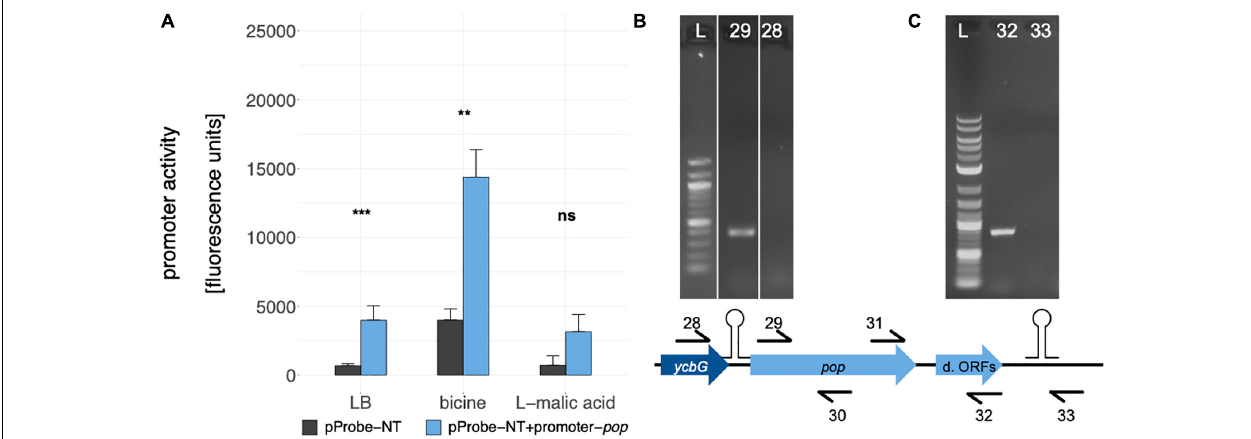
FIGURE 5 | Analysis of the pop transcriptional unit. (A) Promoter activity assay for the promoter of pop , which was introduced in the promoterless GFP vector pProbe-NT. Mean fluorescence units of E. coli Top10 cells with the different constructs in culture conditions as indicated are given. Error bars show standard deviations. Statistical significance between empty vector (gray bars) and the promoter construct (blue bars) was tested with a Welch two sample t -test ( ** p ≤ 0.01; *** p ≤ 0.001; ns, not significant). (B) Test for mono- or polycistronic mRNA. An agarose gel of RT-PCRs is shown. RNA was reverse transcribed in cDNA with pop specific reverse primer 30. Two different forward primers, binding within ycbG (no. 28) or within pop (no. 29), were combined with a pop reverse primer (no. 30). L: 100 bp DNA Ladder (NEB); 28: PCR with primers 28 + 30; 29: PCR with primers 29 + 30. (C) Test for the predicted rho-independent terminator. An agarose gel of RT-PCRs is shown. RNA was reverse transcribed in cDNA with pop specific reverse primers 32 or 33 binding upstream (no. 32) or downstream (no. 33) of the stem loop structure. For PCR, these two reverse primers were combined with a pop forward primer (no. 31). L, 1 kb plus DNA Ladder (NEB); 32: PCR with primers 32 + 31; 33: PCR with primers 33 + 31; d. ORFs, downstream